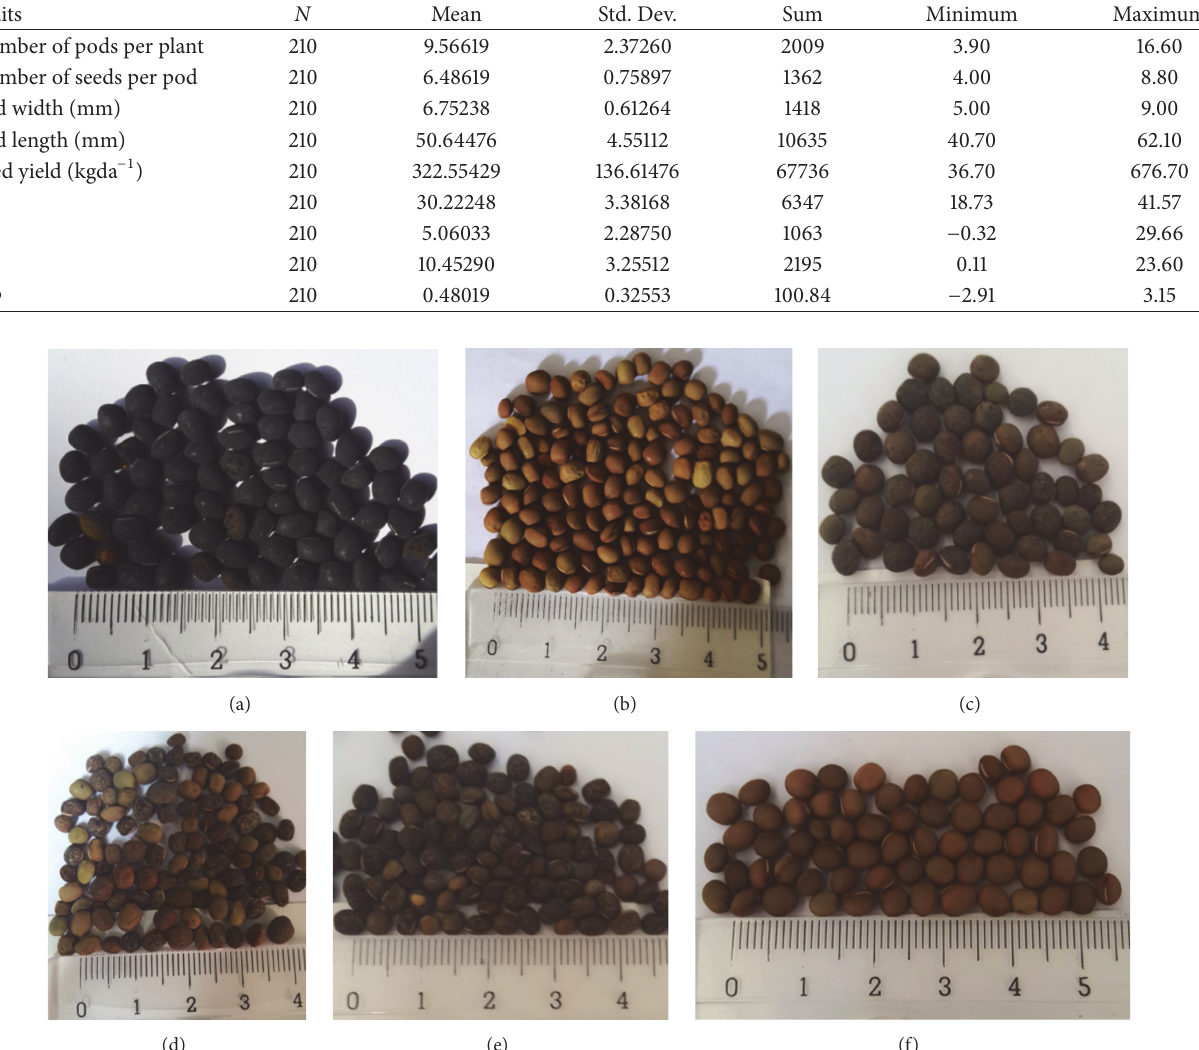
of 62 lines and 8 cultivars was 30.22, 5.06, 10.45, and 0.48,